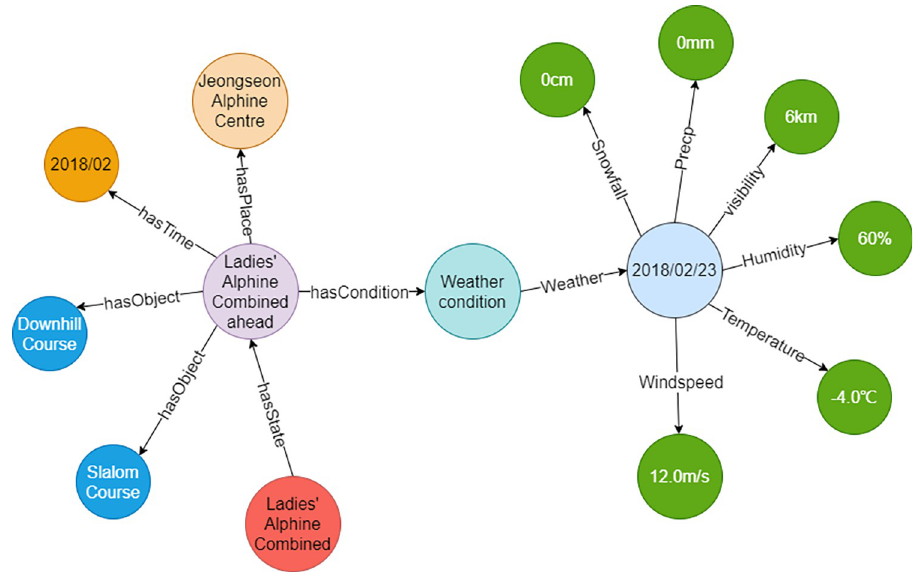
Fig 7. Schematic diagram of the query results—Ladies’ Alpine Combined be rescheduled.